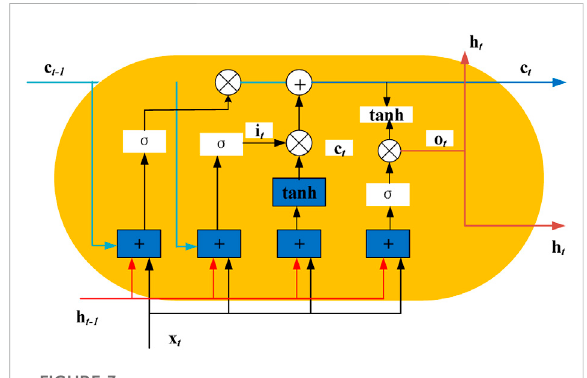
FIGURE 3 The basic structure of the LSTM